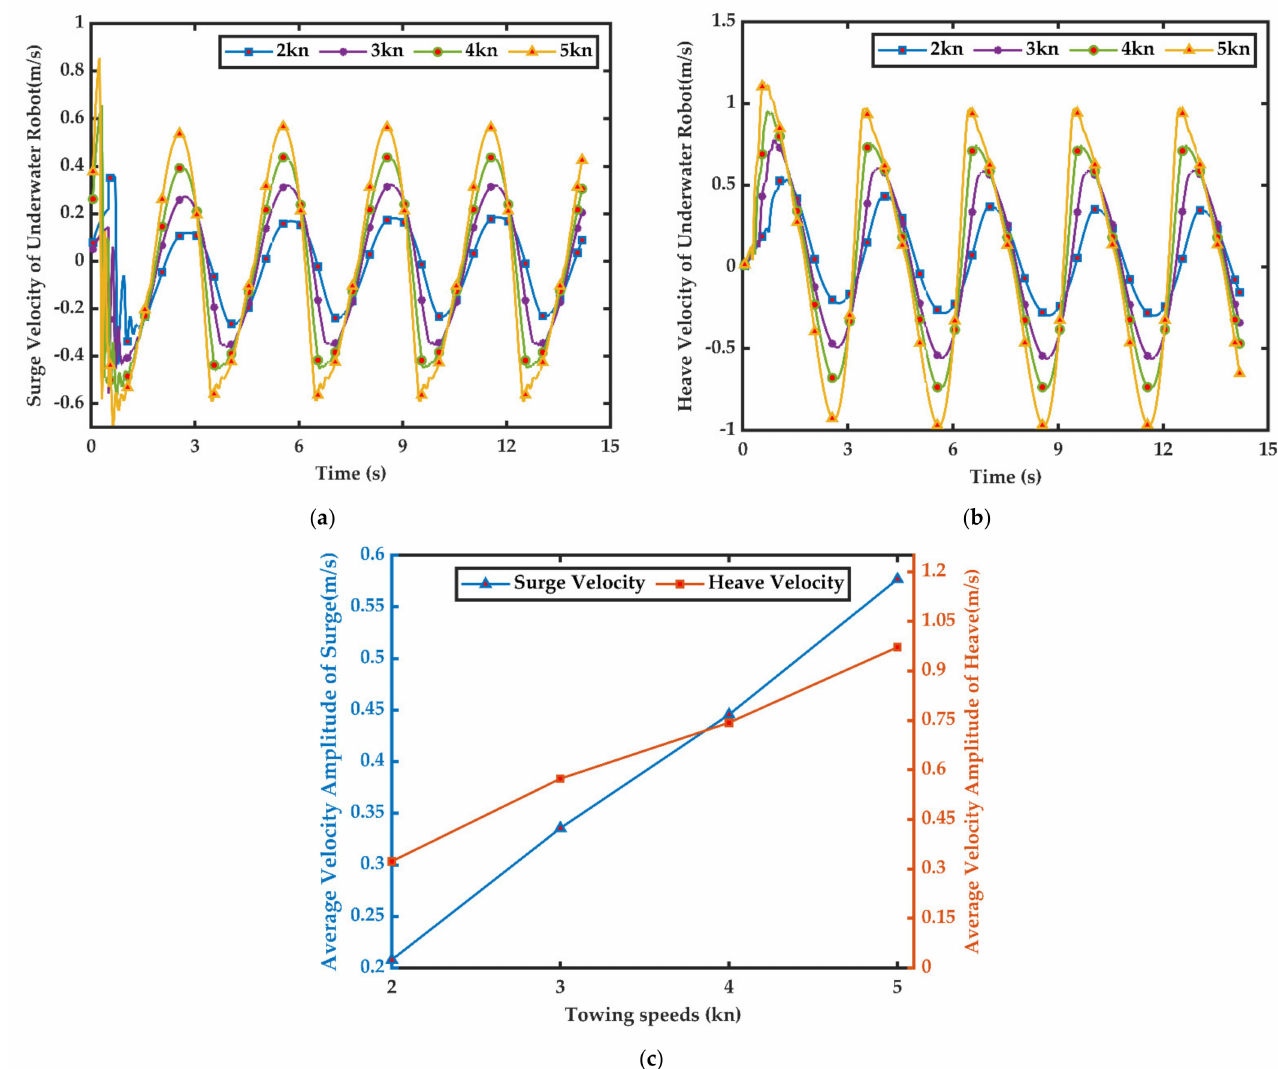
Figure 8. Time history of the velocity of the tethered underwater robot at different towing speeds: ( a ) the surge velocity of the tethered underwater robot; ( b ) the heave velocity of the tethered underwater robot; ( c ) the average velocity amplitude of surge and